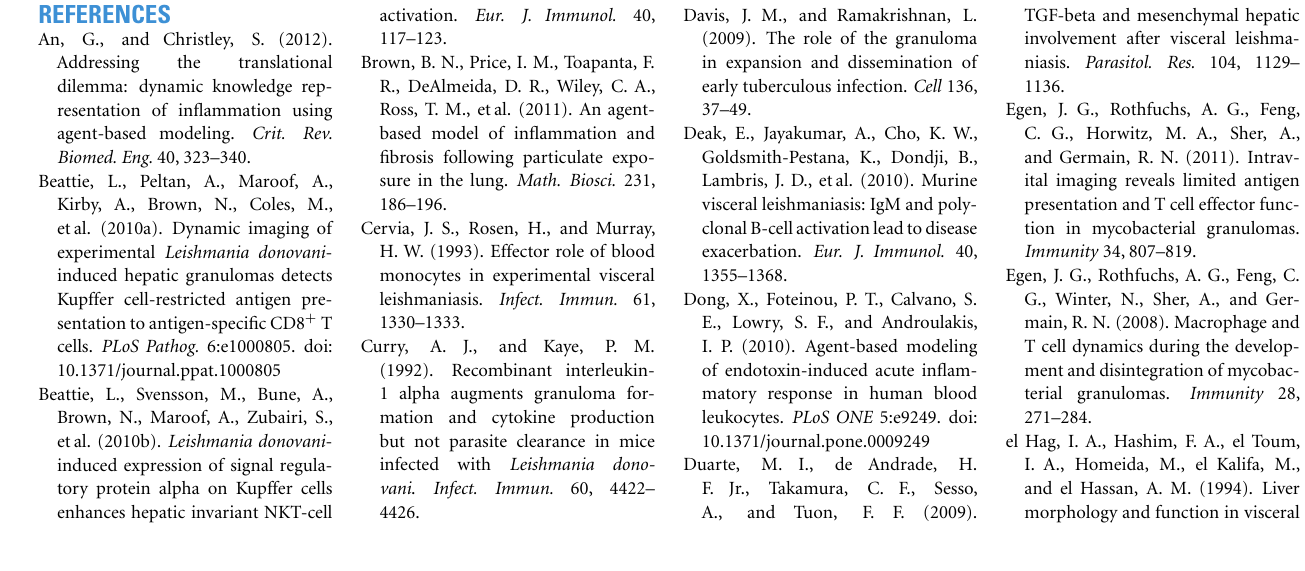
FIGURE 2 |The potential of agent-based modeling for modeling tissue-scale phenomena. ABMs allow the acquisition of time-course data with a custom degree of granularity. (A) A schematic demonstrating how